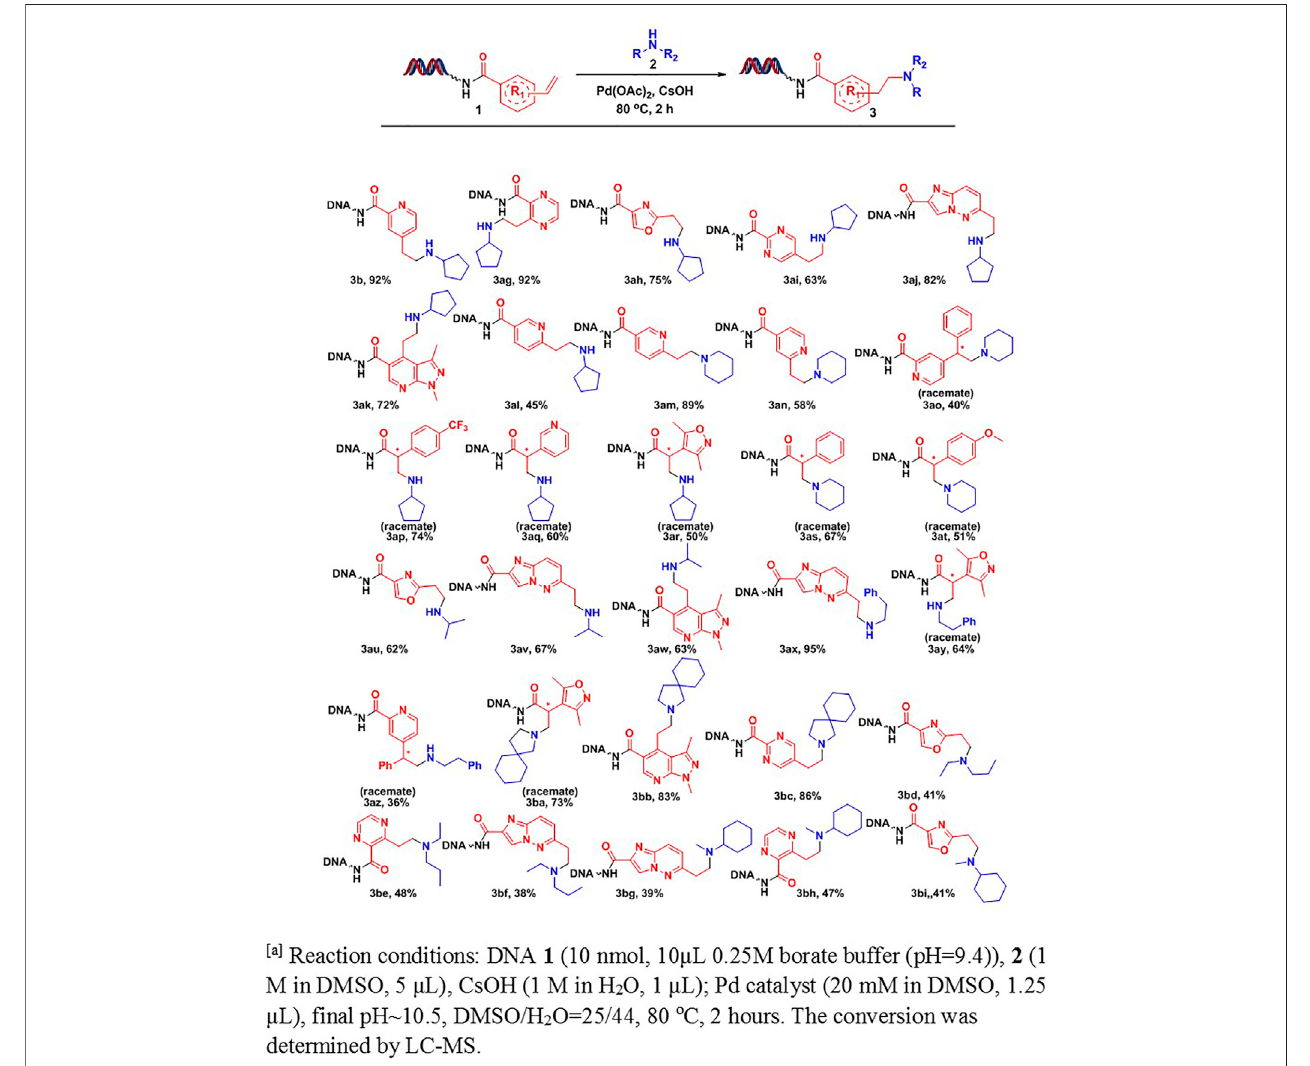
SCHEME 2 | Scope study on DNA-conjugated aryl ethylene Reaction conditions: DNA 1 [10 nmol, 10 μ L, 0.25 M borate buffer (pH = 9.4)], 2 (1 M in DMSO, 5 μ L), CsOH (1 M in